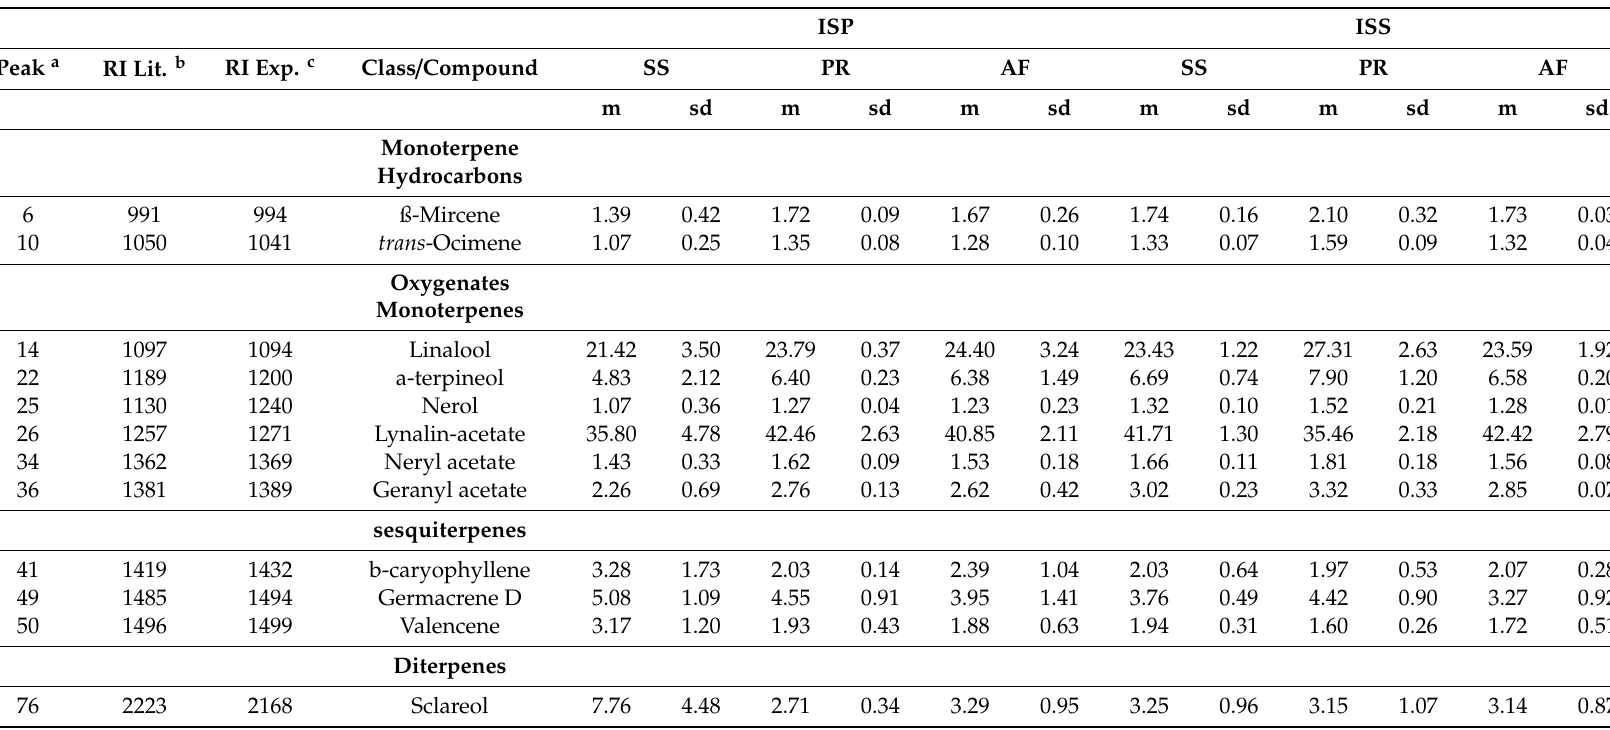
Table 12. Chemical composition of clary sage essential